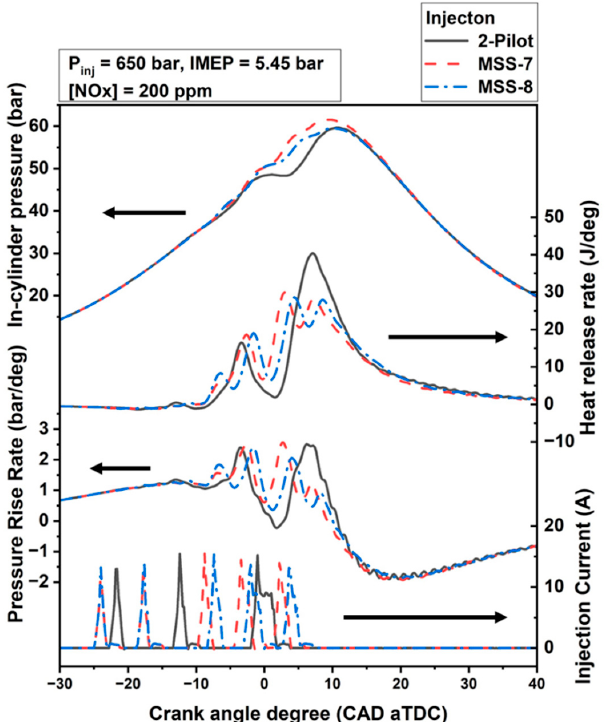
Figure 8. In-cylinder pressure, heat release rate, pressure rise rate, and injection current results for two-pilot strategy and two MSS injection strategies with EGR. two-pilot strategy and two MSS injection strategies with